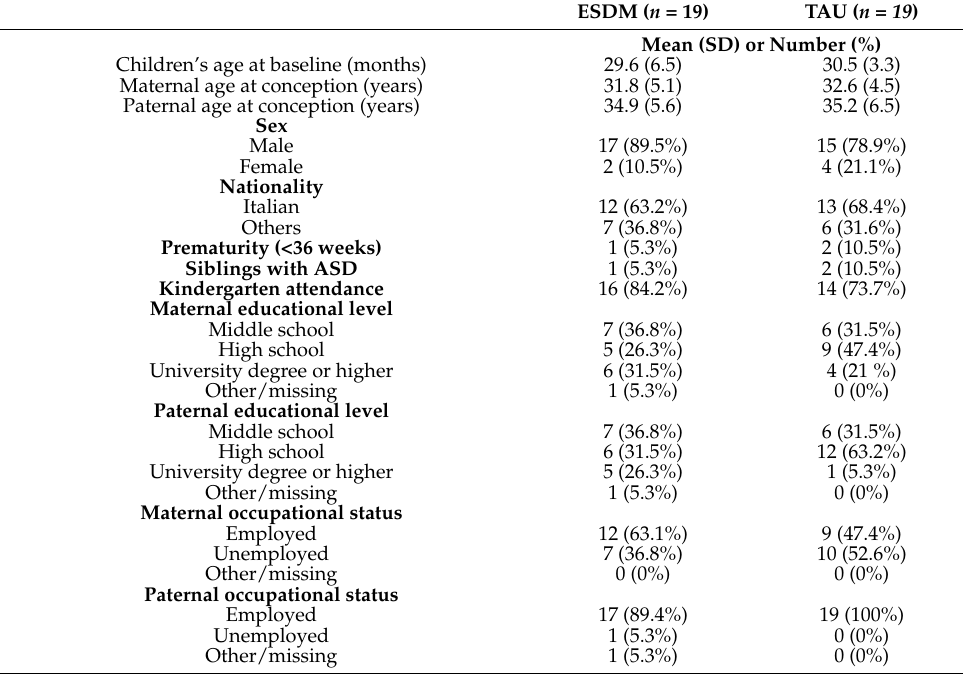
Table 1. Demographic characteristics of the